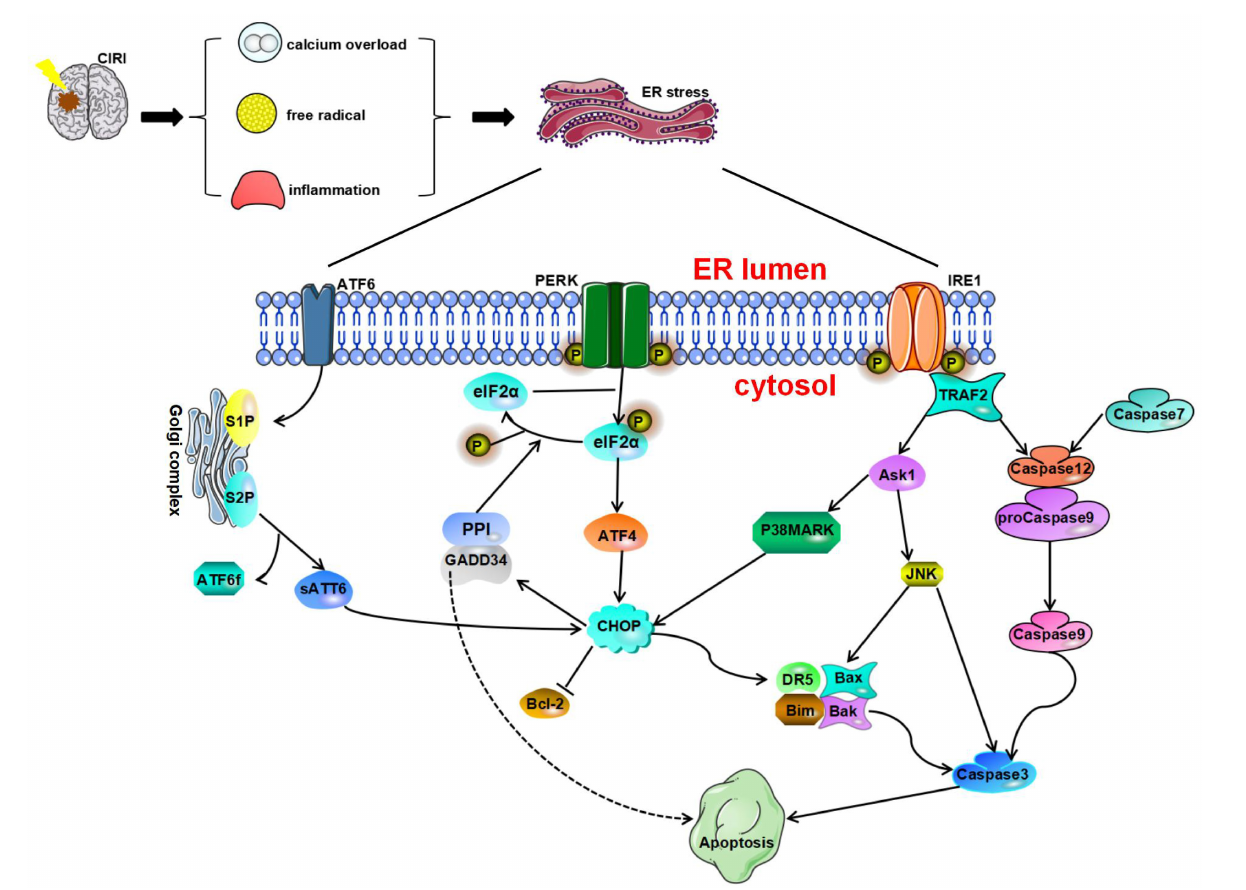
FIGURE 2 | Endoplasmic reticulum stress is a harmful process that induces apoptosis mediated by CAAT/enhancer-binding protein (C/EBP) homologous protein (CHOP), caspase-12, and JNK. Glucose-regulated protein 78 (GRP78) dissociates from protein kinase R-like endoplasmic reticulum kinase (PERK), ATF6, and IRE1 and ultimately initiates proapoptotic signaling pathways by activating CHOP. All three pathways of the UPR can induce CHOP activation. Phosphorylated eukaryotic initiation factor 2 α (IF2 α ) can promote ATF4 expression and then activate the expression of the downstream protein CHOP and induce cell apoptosis. Furthermore, the translation of CHOP is regulated by ATF6. CHOP can increase the expression of Bim, death receptor 5 (DR5), Bax, and Bak and inhibit the expression of Bcl-2 to play a proapoptotic role. The IRE1 pathway and caspase-7 pathway can cause activation of caspase-12. Activated caspase-12 promotes the activation of caspase-3/9 and eventually leads to apoptosis. TRAF2 recruits and activates ASK1, which subsequently phosphorylates and activates